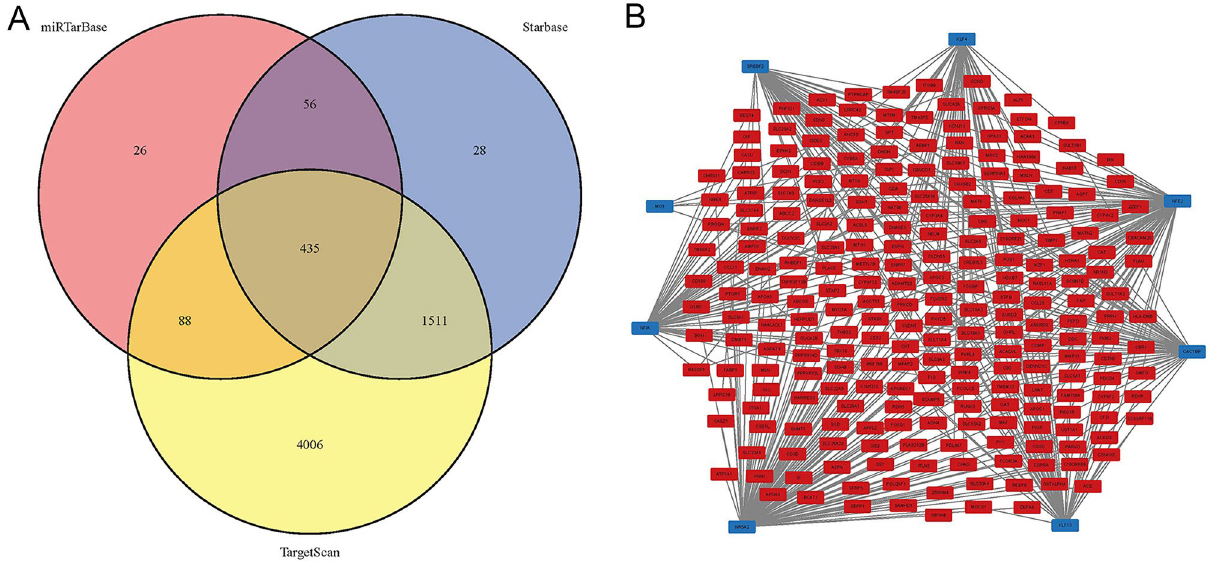
Figure 5. The target miRNA and TF ‐ mRNA regulatory network. ( A ) The Venn diagram of target miRNAs. ( B ) Red represents genes, blue represents TFs. mRNAs messenger RNAs, miRNAs microRNAs, TFs transcription